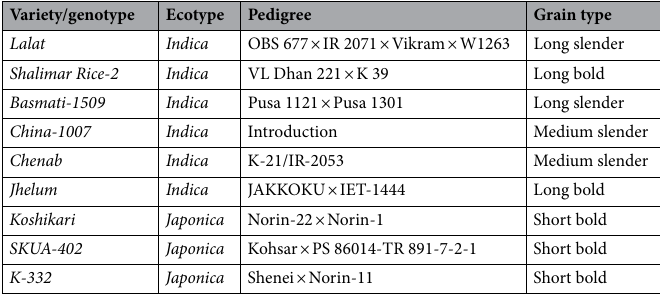
Table 1. Salient features of rice ( Oryza sativa ) germplasm lines/varieties.